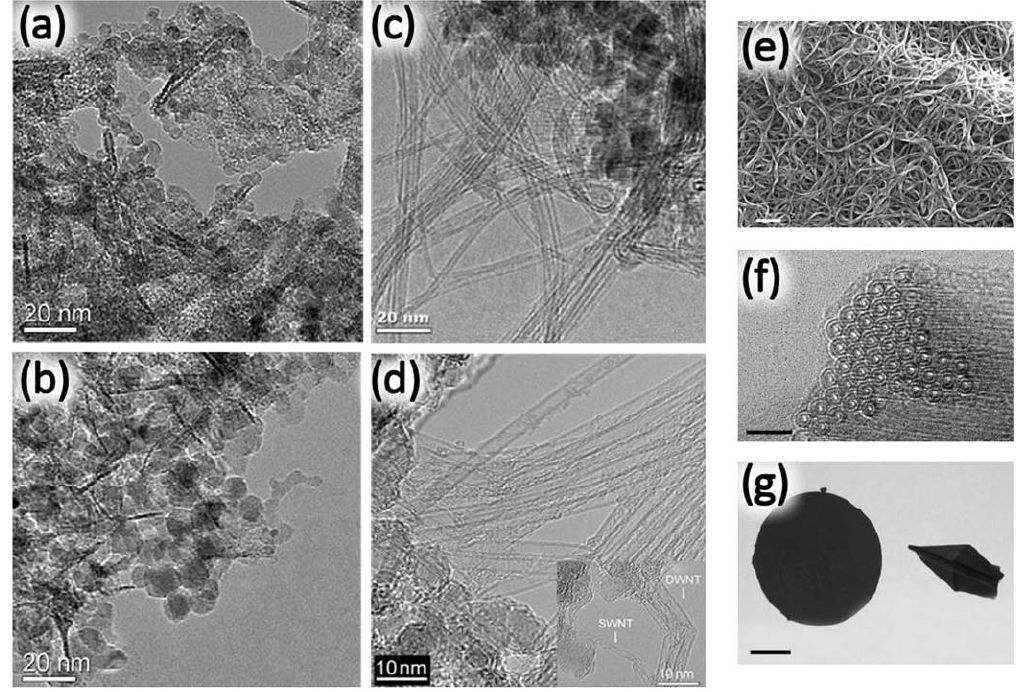
Figure 5. Various methods for DWNT synthesis and layer number control. ( a )–( d ) DWNTs from diameter-controlled Fe nanoparticles supported on MgO. Reproduced with permission from [100], Copyright Elsevier, 2004. Transmission electron microscopy (TEM) images of ( a ) 4-nm and ( b ) 10-nm Fe nanoparticles on MgO and ( c ) small and ( d ) large diameter DWNTs from diameter-controlled Fe nanoparticles ( a ) and ( b ), respectively. Highly bundled DWNTs grown from Fe/MgO with Mo/Al 2 O 3 conditioning catalysts: ( e ) Scanning Electron Microscopy (SEM) image, ( f ) TEM image and ( g ) optical image of flat and origami structured buckypaper. Reproduced with permission from [104], Copyright Nature Publishing Group,